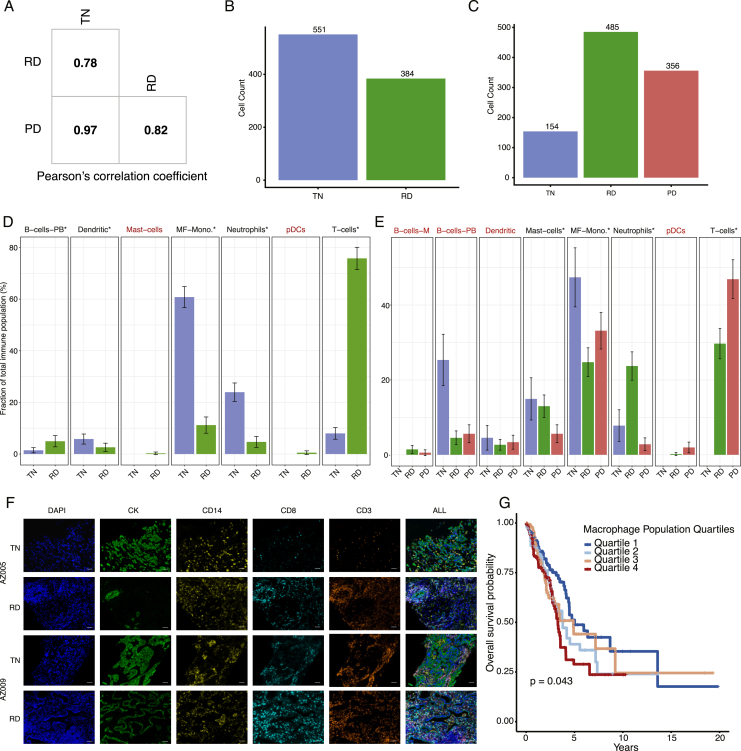
Related to Figure 4(Α) Pairwise Pearson correlations between each treatment group’s immune cell compositions which corresponds to the fraction of each immune cell type’s abundance in the total immune cell population. (B) Total immune cells for each biopsy of patient TH266. (C) Total immune cells for each biopsy of patient TH226. (D) Fraction of each immune cell subtype for the two biopsies of patient TH266. Error bars indicate the 95% confidence interval for the calculated relative frequencies. Asterisks next to the title of each cell type indicate significance (p < 0.01) when using a chi-square test of independence. Titles of non-significant cell types are colored red and lack an asterisk. (E) Fraction of each immune cell sub-type for the three biopsies of patient TH226. Error bars indicate the 95% confidence interval for the calculated relative frequencies. Asterisks next to the title of each cell type indicate significance (p < 0.01) when using a chi-square test of independence. Titles of non-significant cell types are colored red and lack an asterisk. (F) Representative in situ immunofluorescence images from two patients with matched samples at different treatment time points, demonstrating fractional changes in the immune populations of macrophages and T cells. Scale bars correspond to 50 microns. (G) Kaplan-Meier plot of deconvoluted TCGA lung adenocarcinoma data showing the relation between OS and the fraction of macrophages for each patient. Patients were stratified by high and low macrophage fraction.